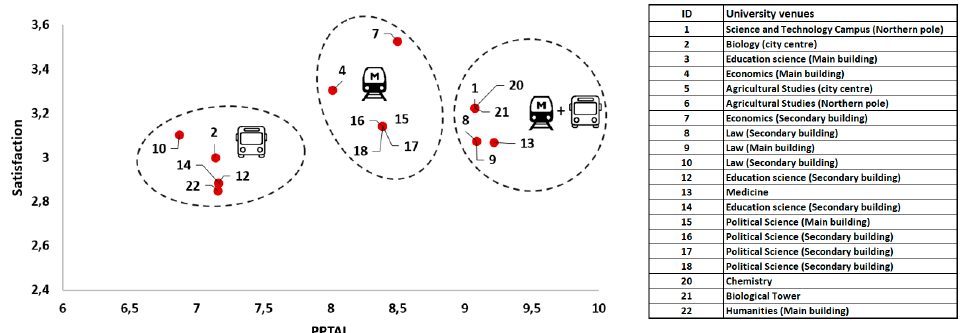
Figure 11. Correlation analysis between PPTAL and global user satisfaction by mode of transport and site location